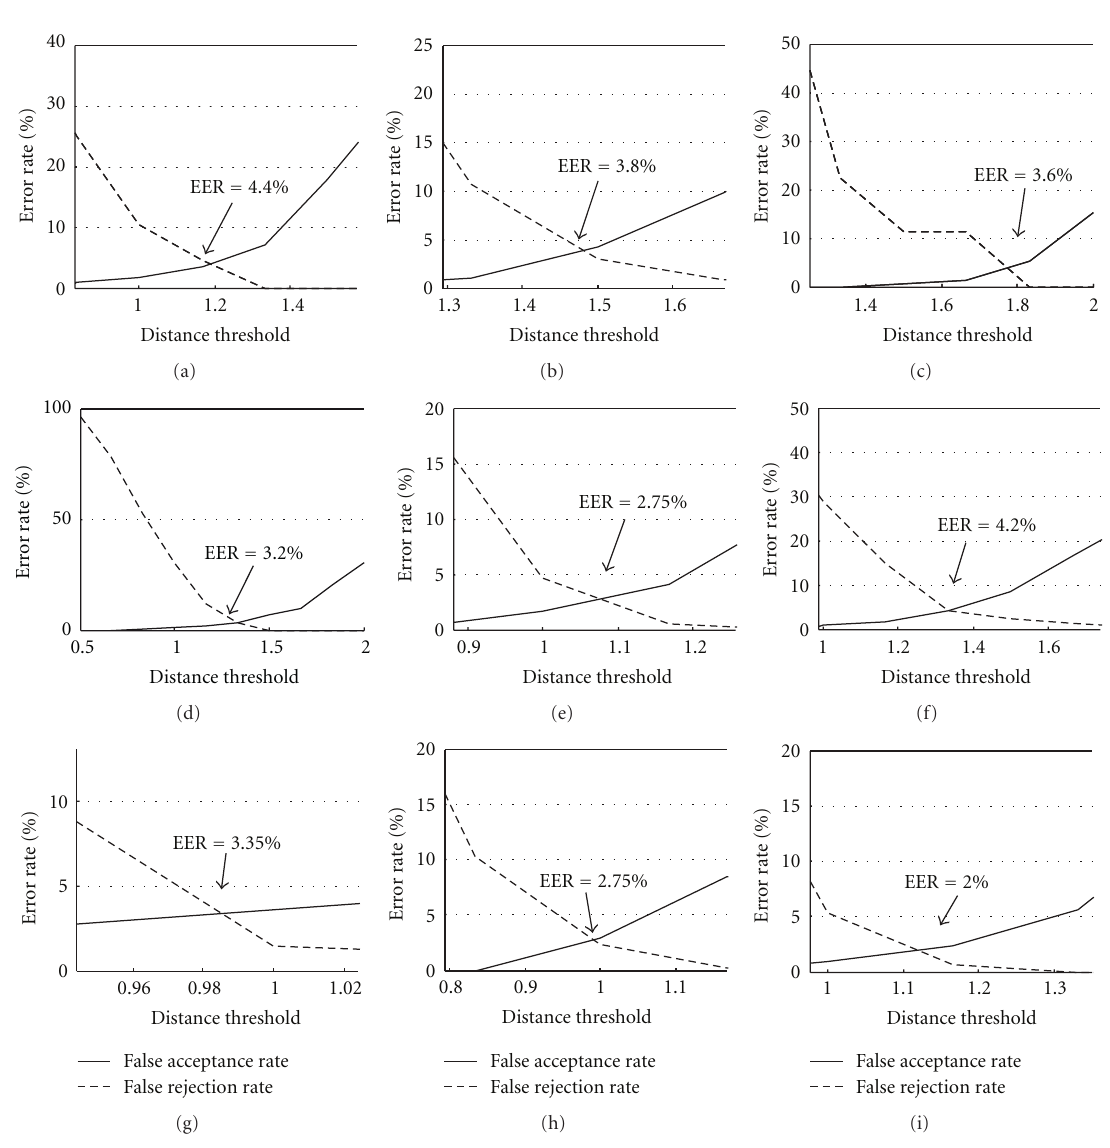
Figure 4: Verification performance with template updating for 9 individuals of the active arousal database.